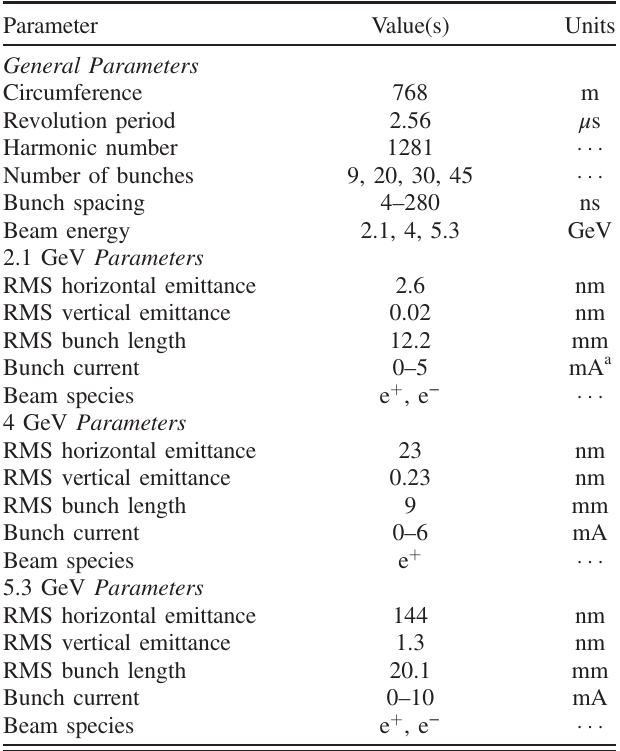
TABLE III. CESR parameters and typical beam conditions for electron cloud mitigation studies.